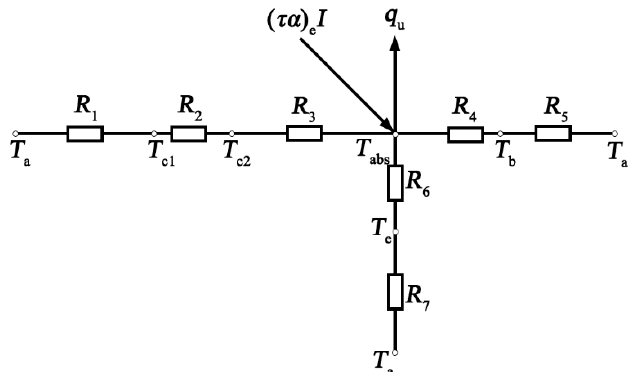
Figure 8. Thermal network diagram of VTBC solar collector in terms of thermal resistance between the two sides.